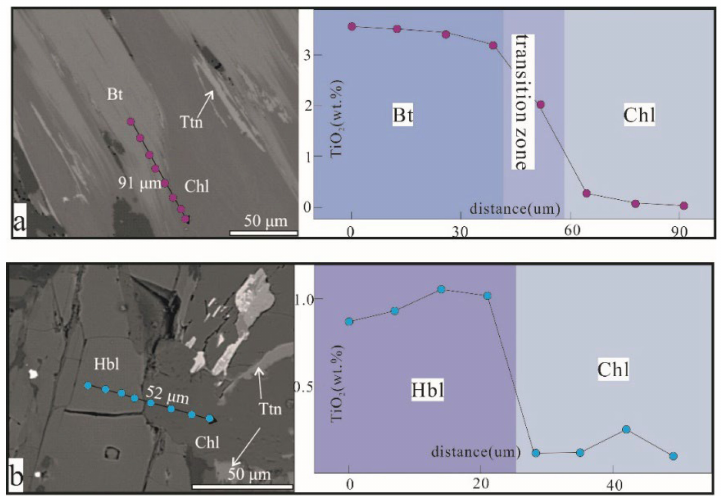
Figure 6. Concentration profiles of TiO 2 through biotite and hornblende to chlorite (modified from [40]). Bt—biotite; Chl—chlorite; Hbl—hornblende;